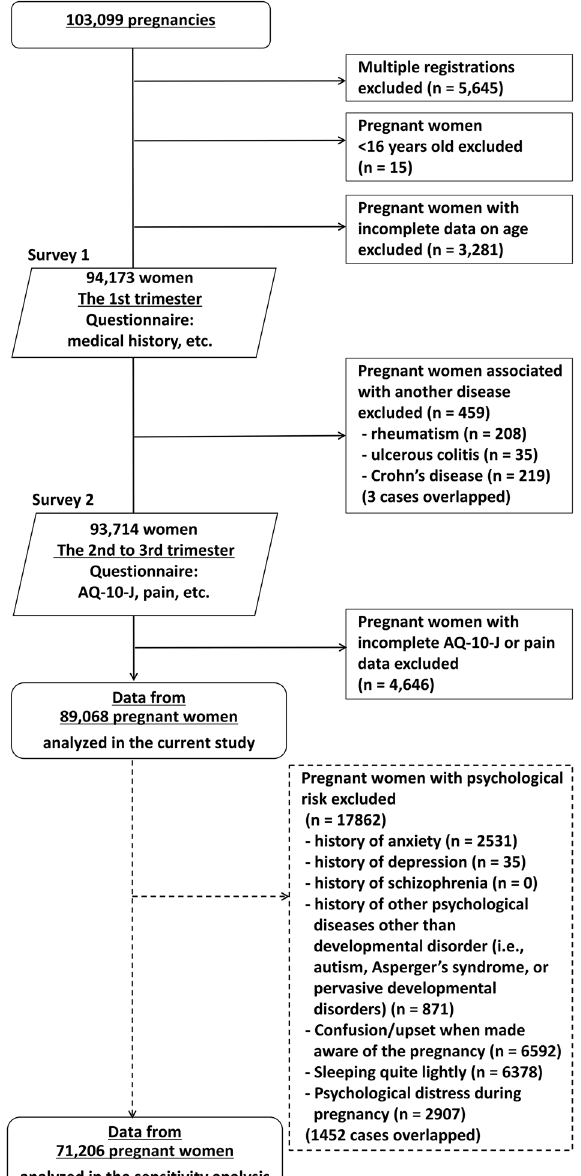
Figure 2. ( a ) Odds ratios for antenatal pain in Model 3; ( b ) odds ratios for antenatal pain stratified by the presence of a history of depression in Model 4. The X axis indicates AQ-10-J scoring group and the Y axis the ORs for mild and moderate-to-severe pain. The bars indicate 95% confidence intervals. P for linearity for the ORs for mild and moderate-to-severe pain by increased AQ-10-J scores were estimated using a general linear model. Regression coefficients for the ORs for the AQ-10-J scoring groups (i.e., slopes) between mild pain and moderate-to-severe pain were also tested using a general linear model. AQ-10 Autism-Spectrum Quotient short form-Japanese version, OR odds